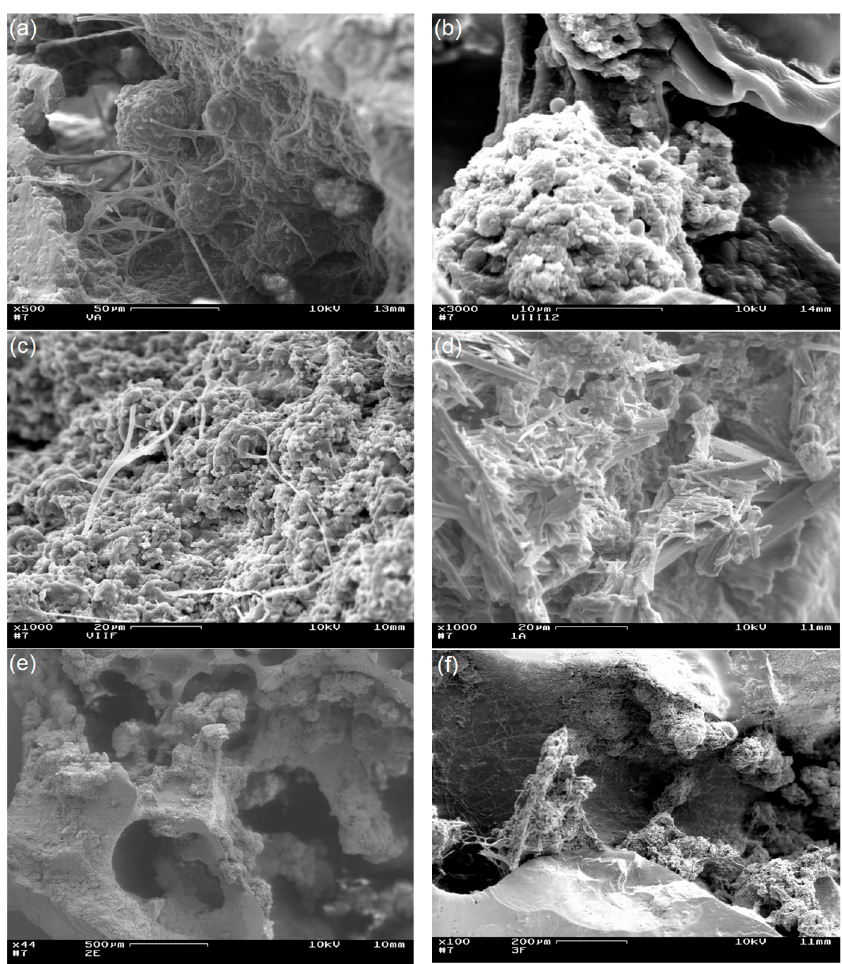
Figure 8. SEM micrographs of PUs subjected to soil degradation: ( a ) PUPFOA and ( b ) PUPFOB, 40 days; ( c ) PUPFOA and ( d ) PUPFOB, 80 days; ( e ) PUPFOA and ( f ) PUPFOB, 120 days.